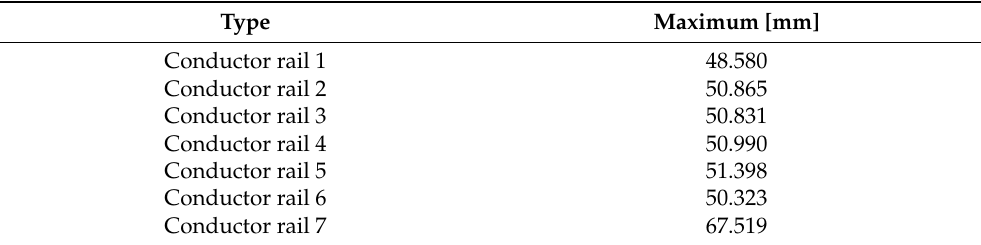
Table 1. Maximum sag of the conductor rail with standard